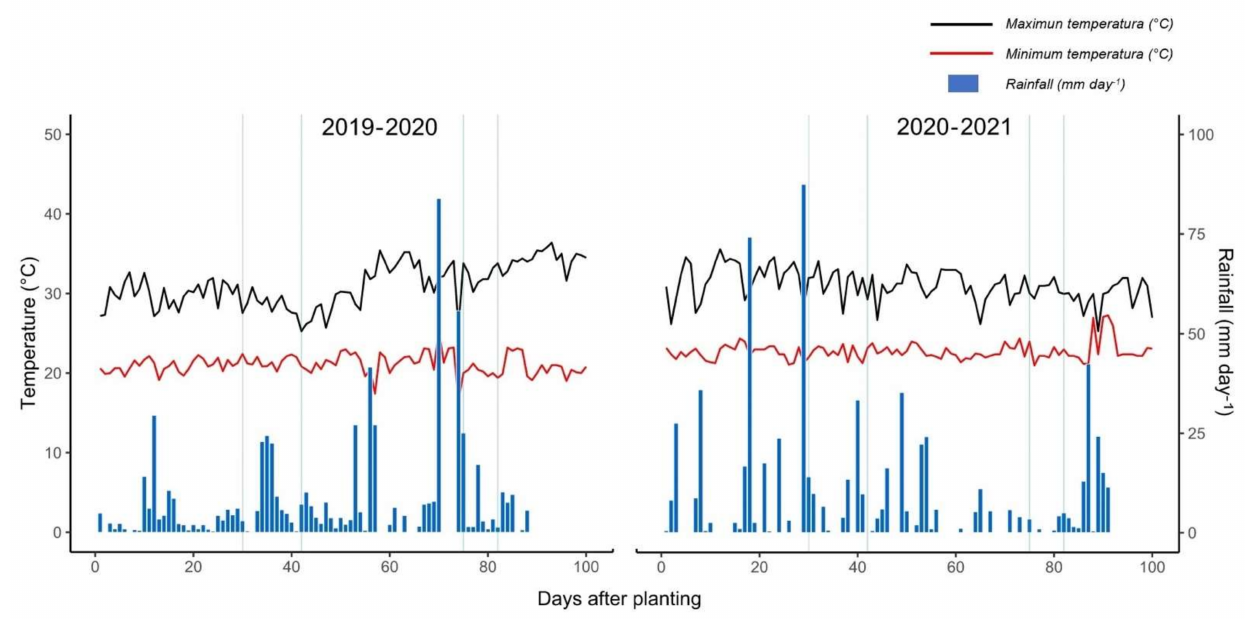
Figure 8. Distribution of rainfall and maximum/minimum temperatures during the crop growing period at the Macagual Research Center in Colombia in two seasons: October 2019–January 2020 ( left ); and October–January 2021 ( right